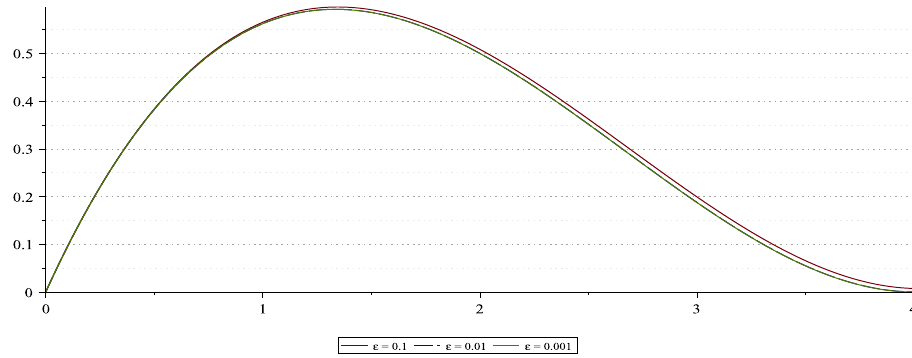
Figure 3. The relative lateral separation z 1 ( t ) for varying ε .